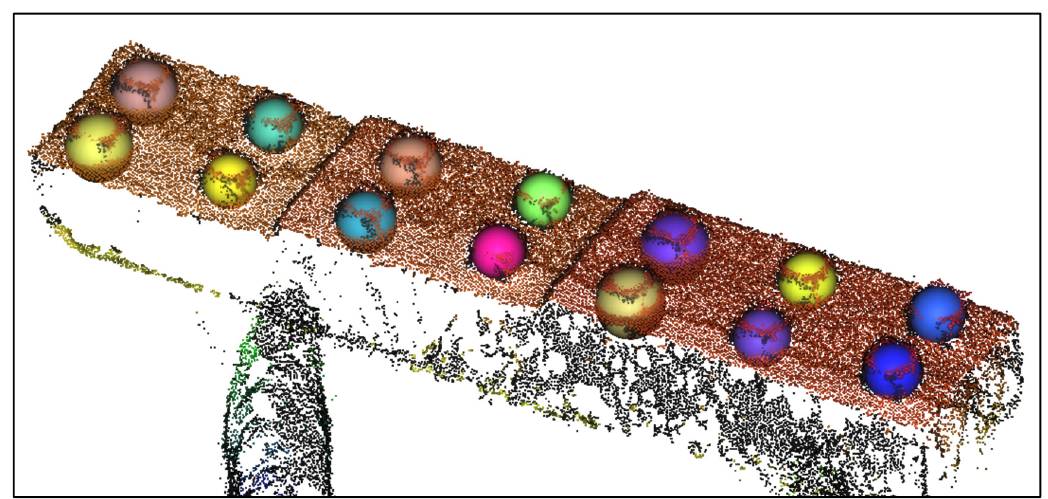
Figure 5. RANSAC for sphere fitting of the pier pad points.